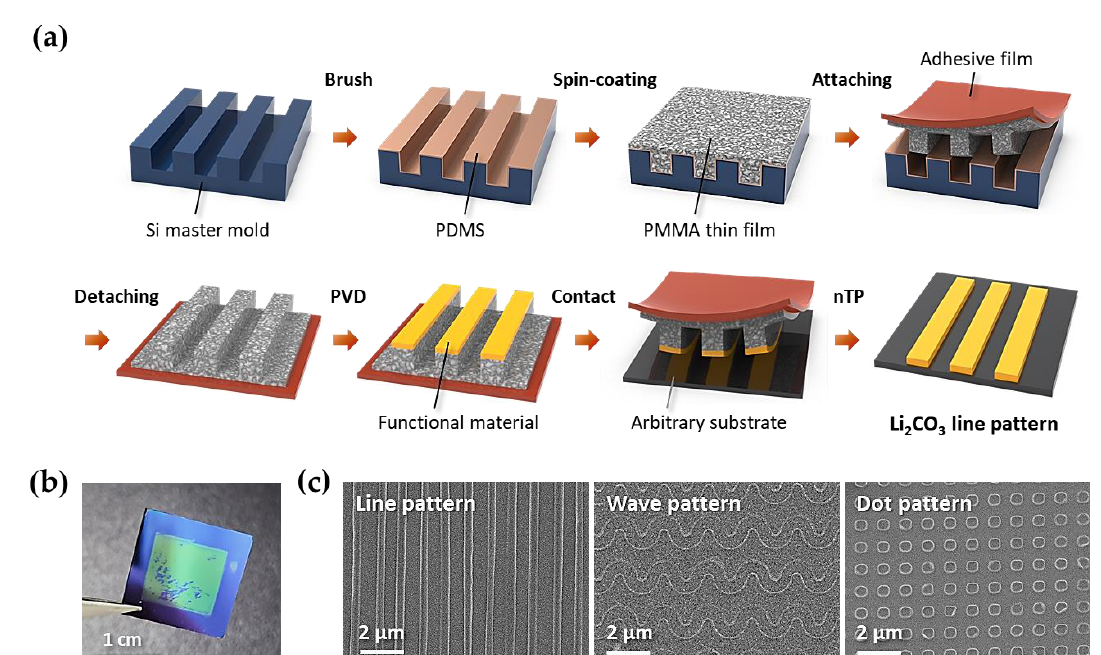
Figure 3. Various Li 2 CO 3 patterns formed by the nTP process. ( a ) Procedure of the pattern formation of Li 2 CO 3 nanostructures by nTP. ( b ) Photographic image of a transfer-printed Li 2 CO 3 pattern on a SiO 2 /Si substrate. ( c ) Various pattern geometries obtained by the nTP